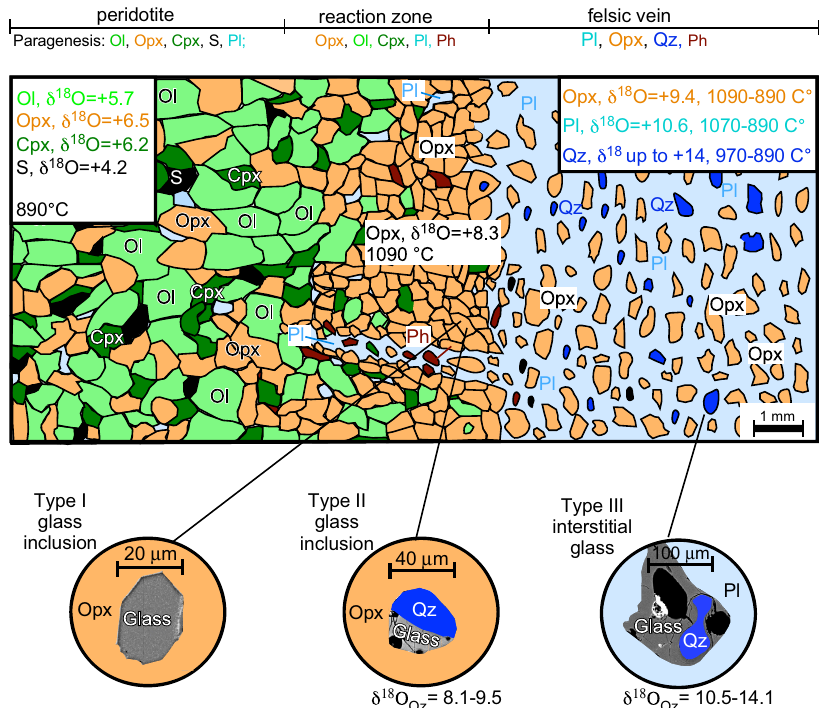
Fig. 3 | Mineralogy and isotopic variations along the xenolith. Sketch reporting the mineralogical variation observed in the composite xenolith TL112 and the related oxygen isotopic values (expressed as δ 18 O ‰ , with respect to the SMOW standard). The observed variation allows to schematize within the xenolith three distincttexturaldomains:peridotite,reactionzone,felsicvein.Emphasisisgivento